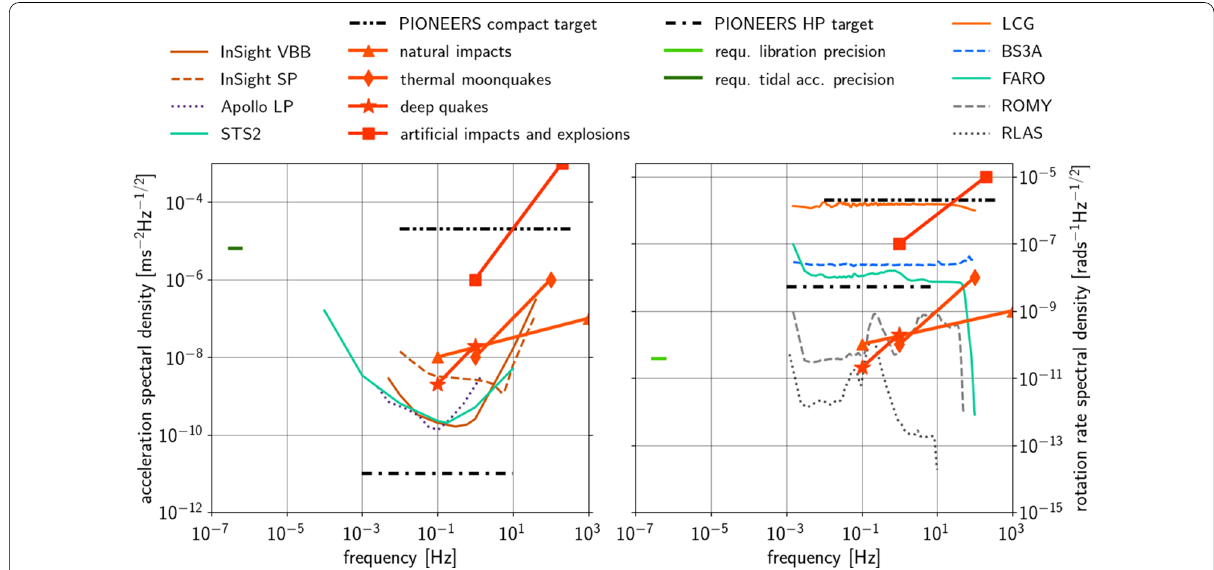
Fig. 8 Expected signal levels on the moon. For forced librations and tidal accelerations, the required resolution is shown. Additionally, self‑noise levels of commonly used sensors are shown (see Fig.